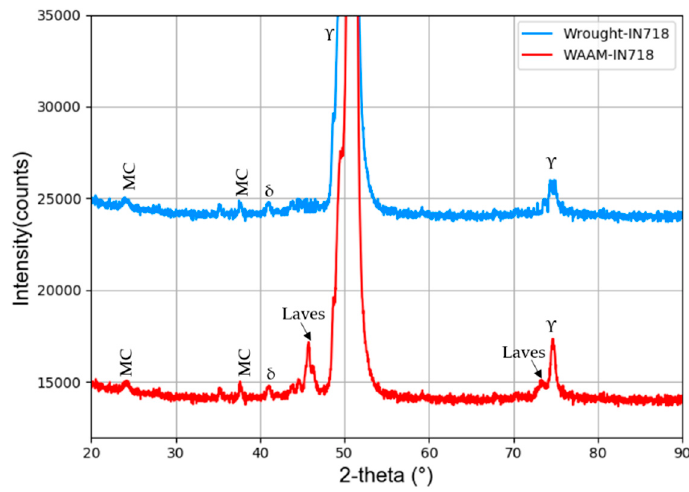
Figure 6. X-ray diffraction patterns of IN718 produced by WAAM and Wrought.